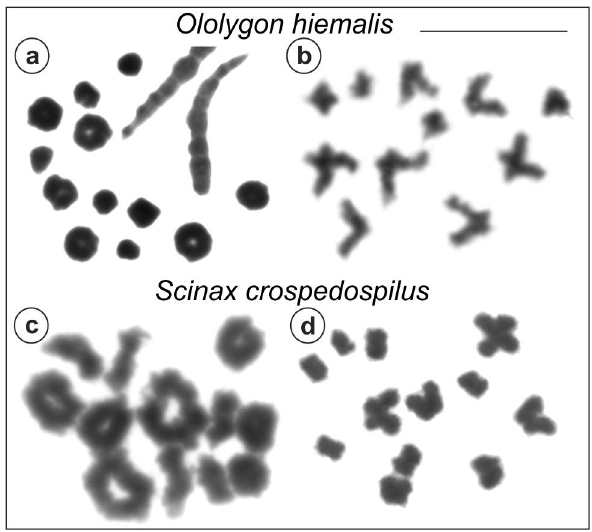
Figure 8. Meiotic cells in males of Ololygon hiemalis (a, b) and Scinax crospedospilus (c, d) . a, c Meta- phase I with 12 bivalents b, d Metaphase II with 12 chromosomes. Bar = 10